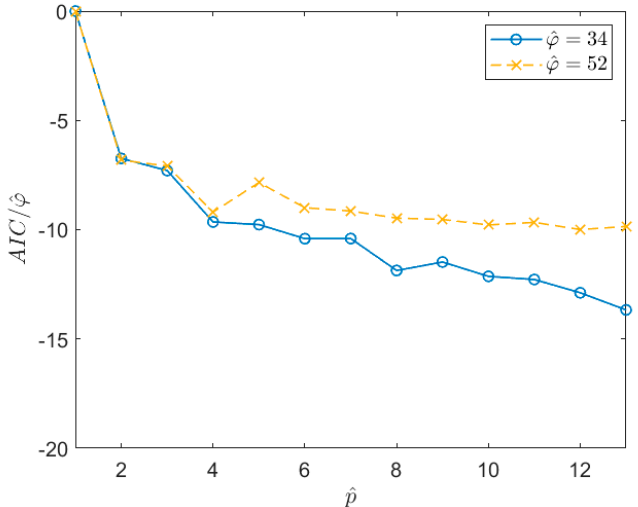
Figure 4. Trend of the AIC index, normalized with respect to the number of the auto − covariance samples used for the estimation procedure, ˆ ϕ . The curves refer to two different time series x ( n ) of a Type 1 signal in Table 1 sampled at 1 Hz for 1 h.